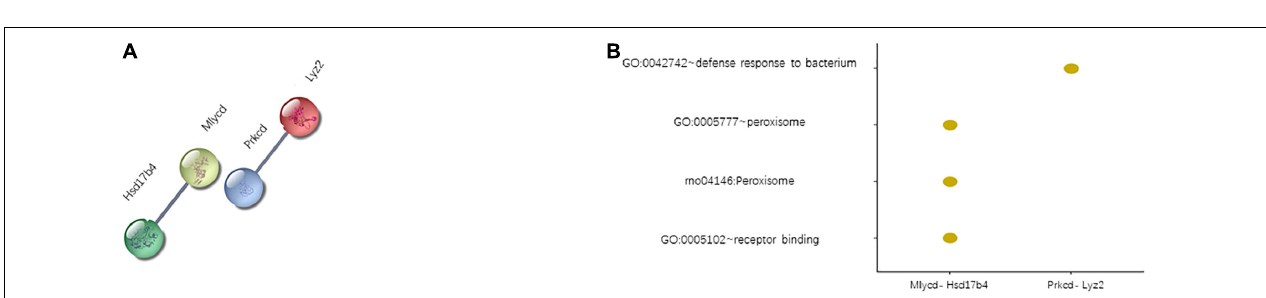
FIGURE 2 | The comparison of differentially expressed genes (DEGs) in the cerebral artery, heart, and adipose and biological processes related to housekeeping genes. (A) The comparison of DEGs in the heart, adipose, and cerebral artery. (B) The biological processes related to housekeeping genes.